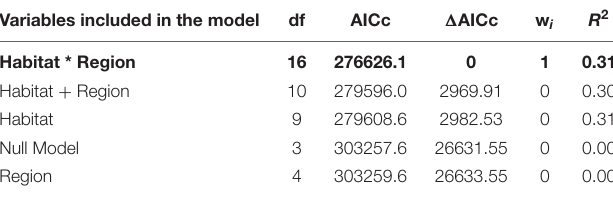
TABLE 3 | Rank of general linear mixed effect models explaining variation in habitat use of herring gulls by habitat category (habitat) and region using Akaike’s